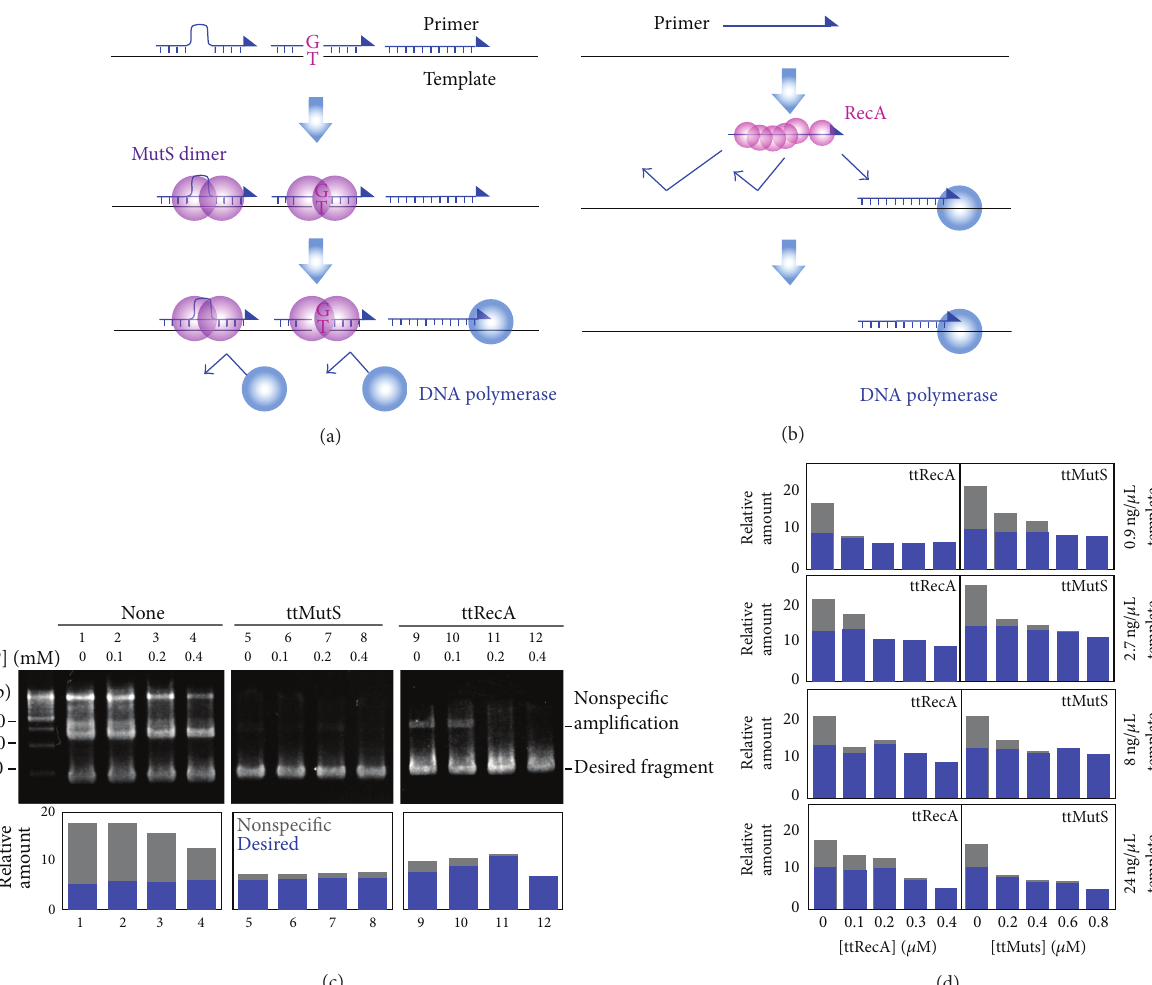
Figure 1: The error-suppressing effects of ttRecA and ttMutS in the presence of ATP. (a) A schematic representation for the mechanism by whichttMutSsuppressesnonspecificamplificationsduringPCR.AttMutSdimerrecognizesmismatchedbasesgeneratedbymishybridization of the primer and blocks the approach of DNA polymerase. (b) A schematic representation for the mechanism by which ttRecA suppresses nonspecific amplification during PCR. ttRecA promotes proper priming for PCR. (c) A 423 bp region of the ttha1806 gene was amplified by using Takara LA Taq in thepresence of 0 to 0.4mM ATP. Lanes 1–4, 5–8, and 9–12 are theresults of thereaction without ttMutS or ttRecA, with 0.8 𝜇 M ttMutS, and with 0.4 𝜇 M ttRecA, respectively. The amounts of the amplified fragments were quantified by using the ImageJ software [9] and are shown as bar graphs in the lower panels, where gray and blue indicate nonspecific and desired amplifications, respectively. (d) A 423bp region of the ttha1806 gene was amplified by using Takara LA Taq in the presence of 0.9, 2.7, 8.0, or 24 ng/mL template DNA ( T. thermophilus HB8 genomic DNA). The relative amounts of the amplified fragments are shown. Gray and blue bars indicate nonspecific and desired amplifications,